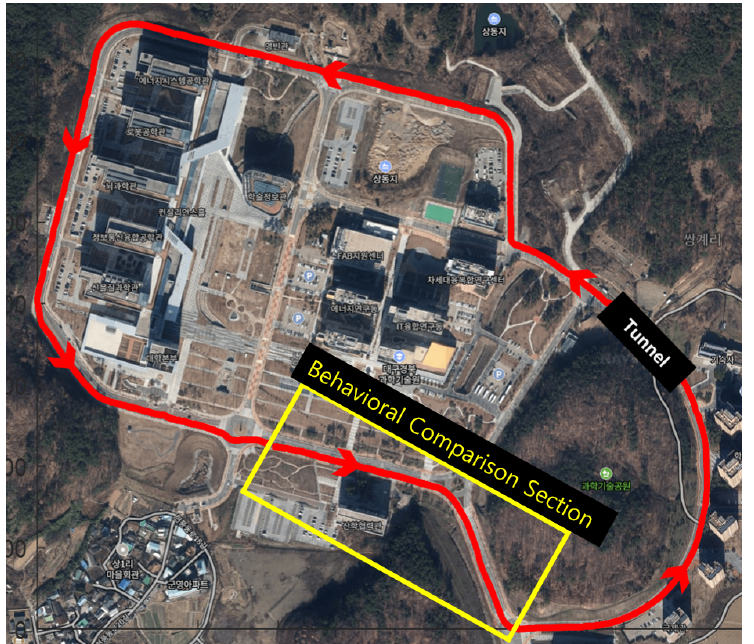
Figure 15. Driving path of a vehicle in real-world test.